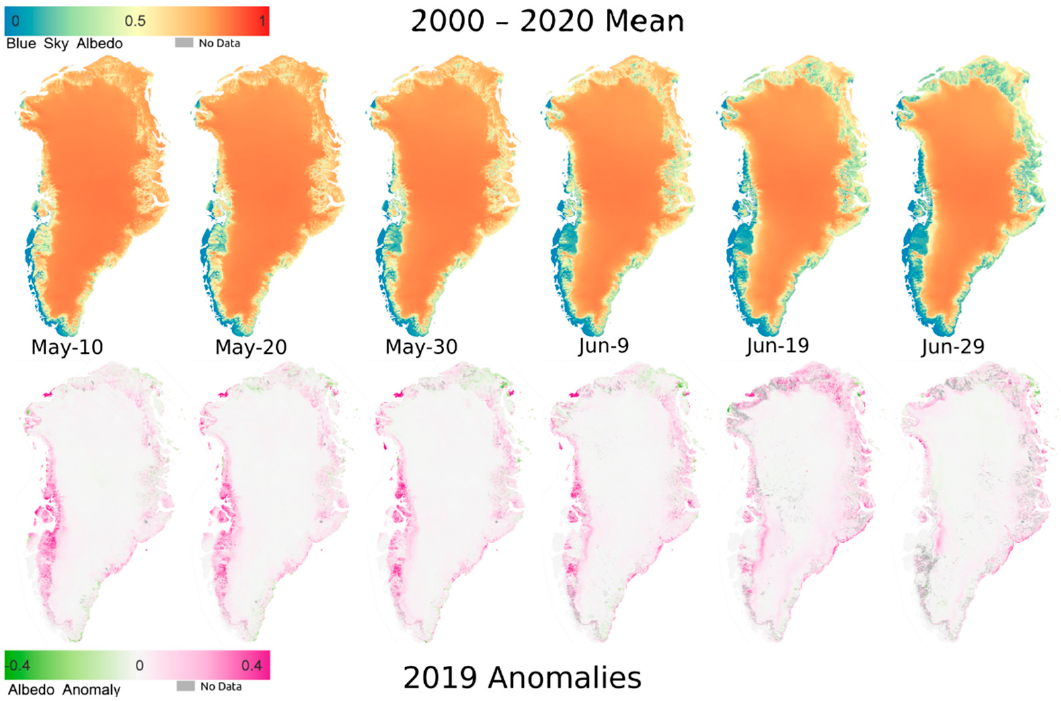
Figure 2. MODIS 500m gridded MCD43 blue-sky albedo anomalies time series for the 2019 melt season ( bottom ) compared to the mean ( top ). Note in particular the rapid melt along the western coast.